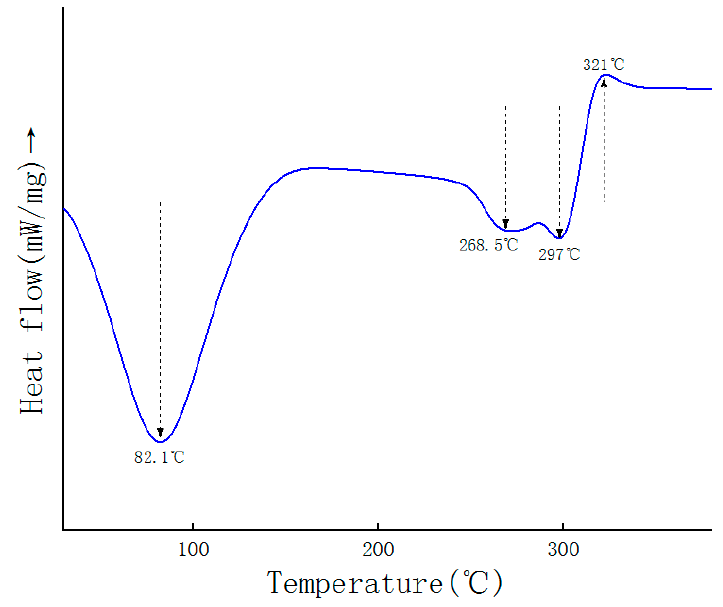
Figure 3. The DSC curve of GEP-1.